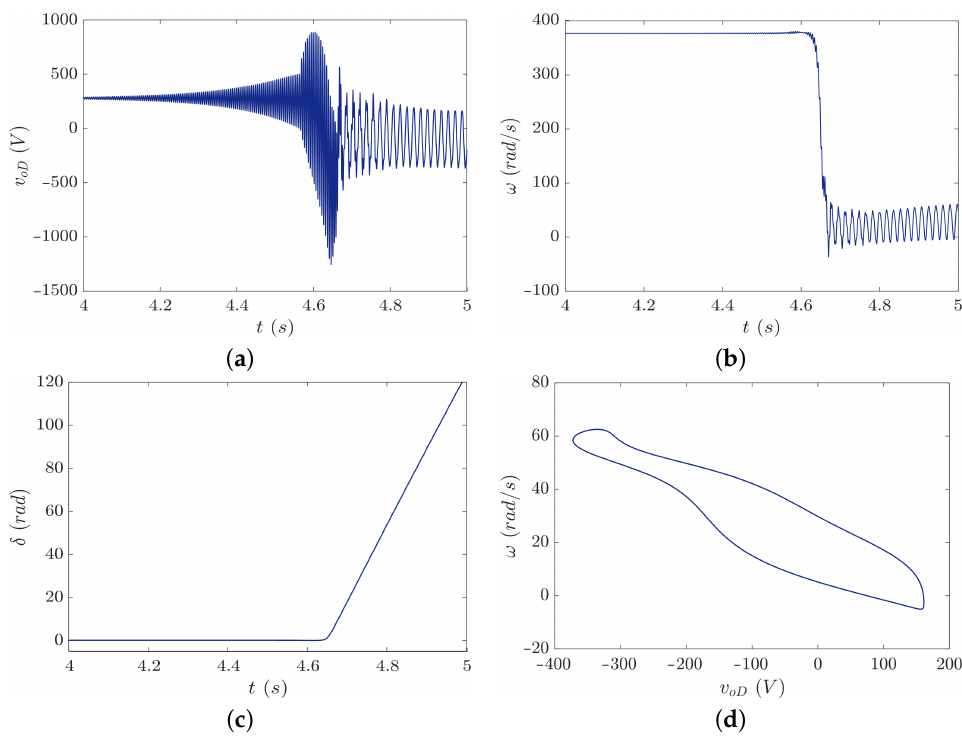
Figure 16. The behavior of the system when the loss of synchronism occurs at P 0 = 3.89 p.u.: ( a – c ) Time response of the voltage, angular velocity, and angle. ( d ) Steady-state phase